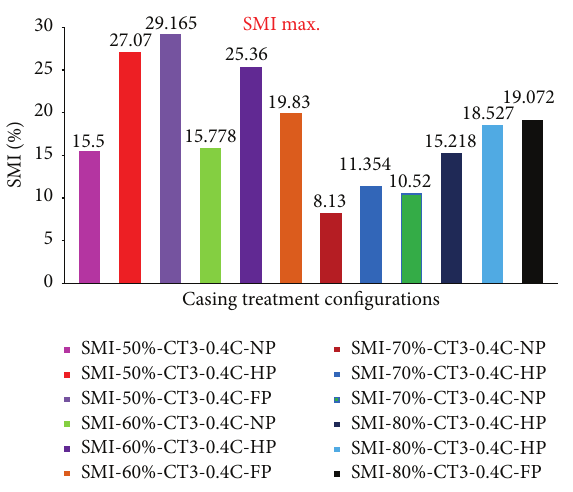
Figure 8: Stall margin improvements with casing treatment config- urations at 40% axial coverage.